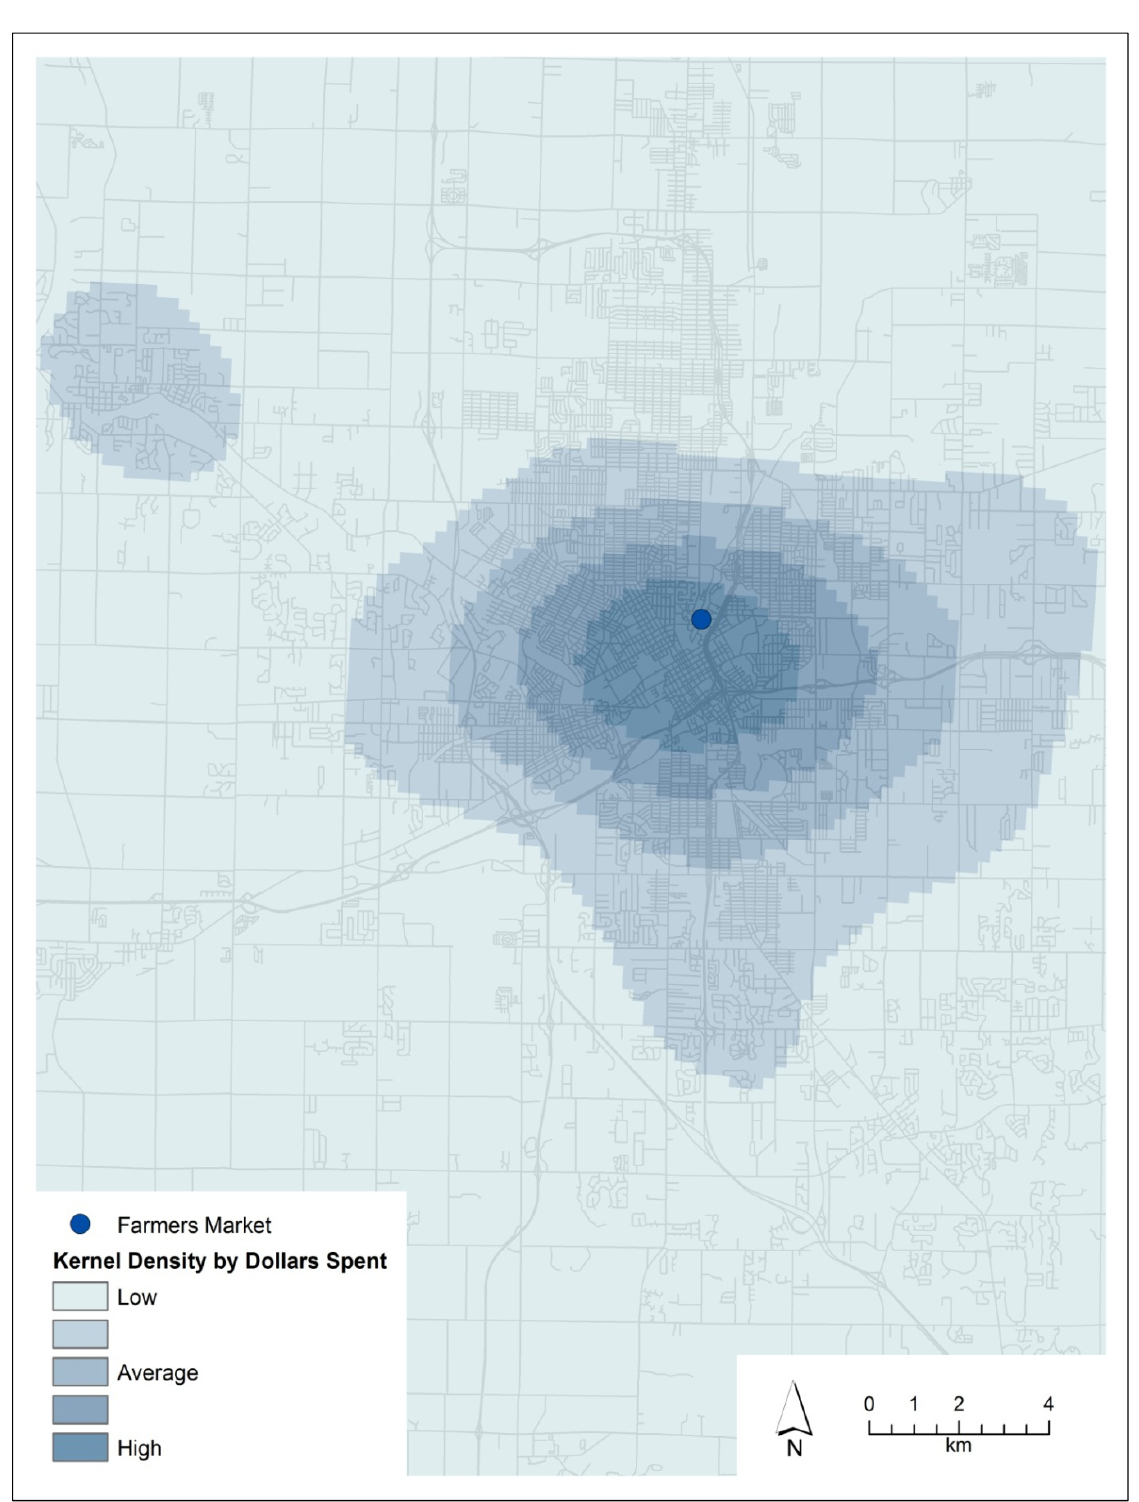
Figure 3. Kernel Density of Flint Farmers’ Market Customers Weighted by Dollars